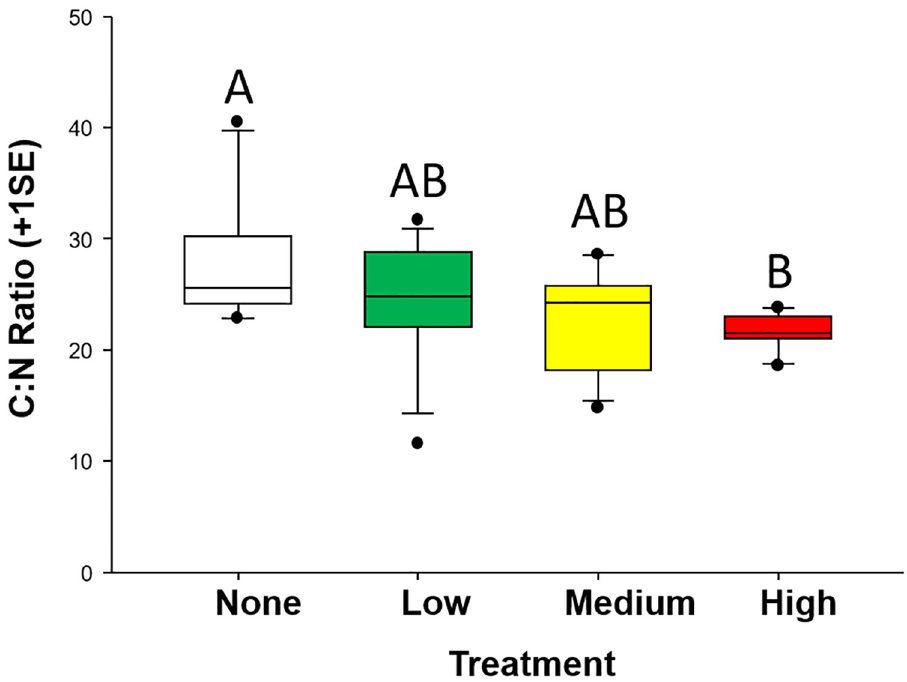
Fig 1. Carbon:nitrogen (C:N) ratio in plant tissues. C:N ratio in plants grown in no (white), low (green), medium (yellow), and high (red) oil-contaminated sediments. Different letters indicate statistically significant differences.